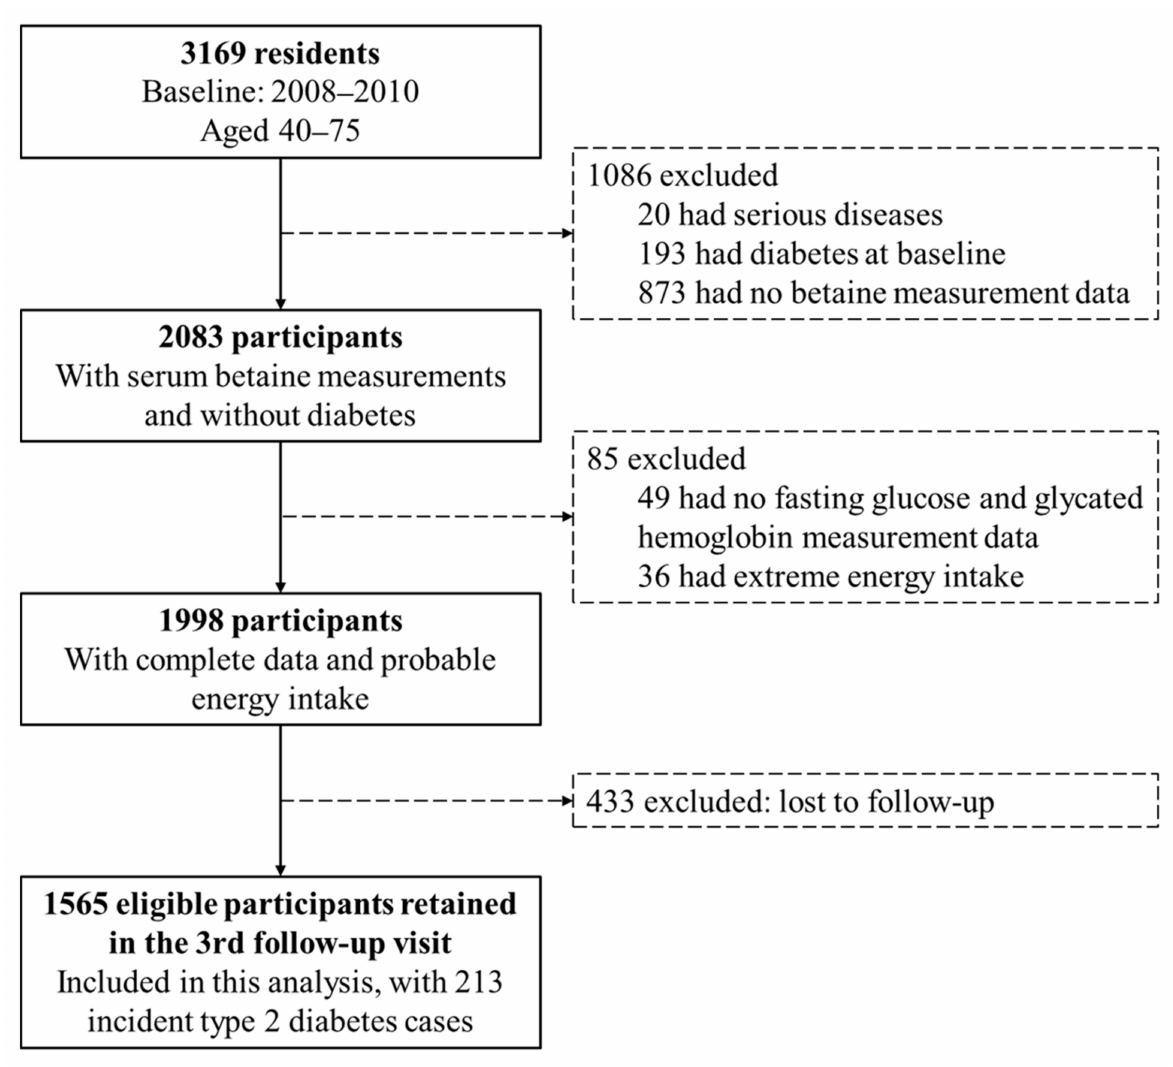
Figure 1. Flowchart of selection of participants from the Guangzhou Nutrition and Health